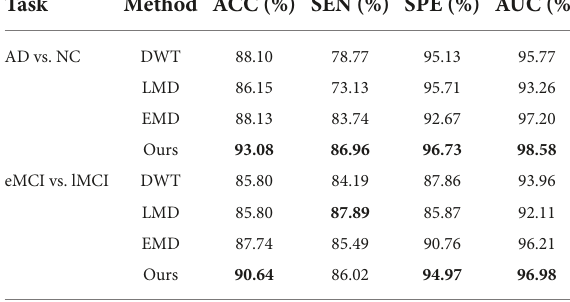
TABLE 4 Classification results of four signal decomposition methods in two tasks.